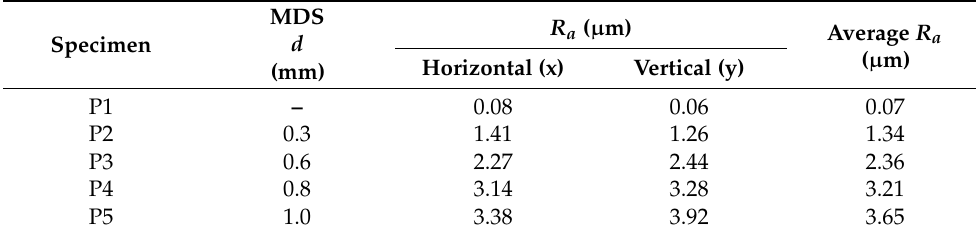
Table 3. The calculation results of surface roughness of